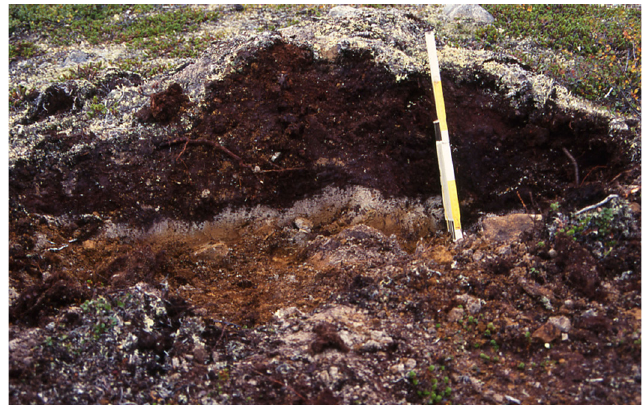
Figure 7: Organic (peaty) hummock overlying a Podzol (Staloskaidi, northern Finnish Lapland) at about 340 m elevation. The hummock developed from litter accumulating around the stem base of a polycormic mountain birch. We conclude that this birch died due to defoliation during episodic mass-outbreaks of the autumnal moth ( Epirrita autumnata ) and subsequent very cold summers combined with increased reindeer impact. Photo taken by the author, September 2000.